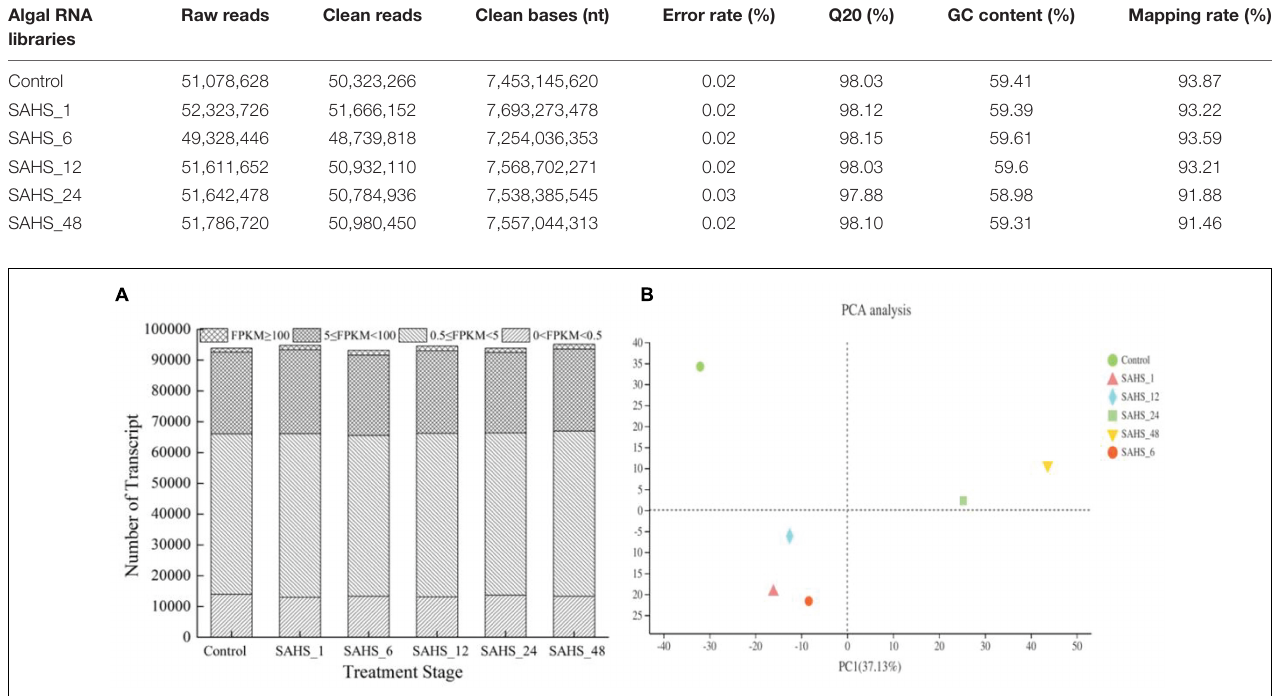
FIGURE 2 | Global expression profiling of H. pluvialis unigenes at different treatment stages. (A) Numbers of detected unigenes in each library. (B) Principal component analysis of the RNA-Seq libraries.